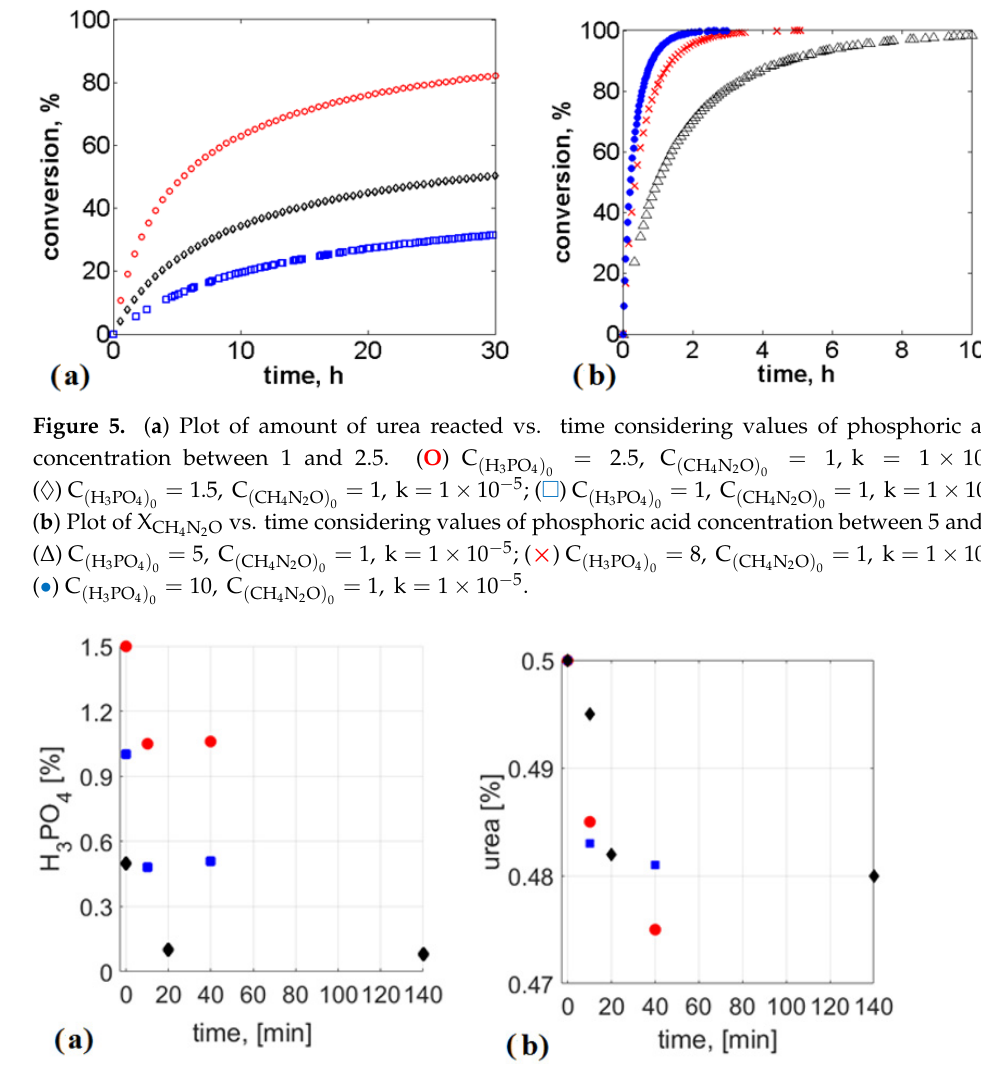
Figure 6. Variation of H 3 PO 4 ( a ) and urea concentration ( b ) in experiments performed using a molar ratio of 0.66 mol H 3 PO 4 /mol urea ( ♦ ), 1.22 mol H 3 PO 4 /mol urea ( ▪ ), 1.5 mol H 3 PO 4 /mol urea ( ● ).